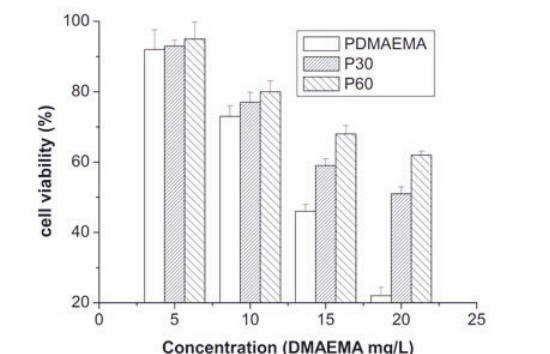
Figure 8. Transfection efficiency of various polymers with different N/P